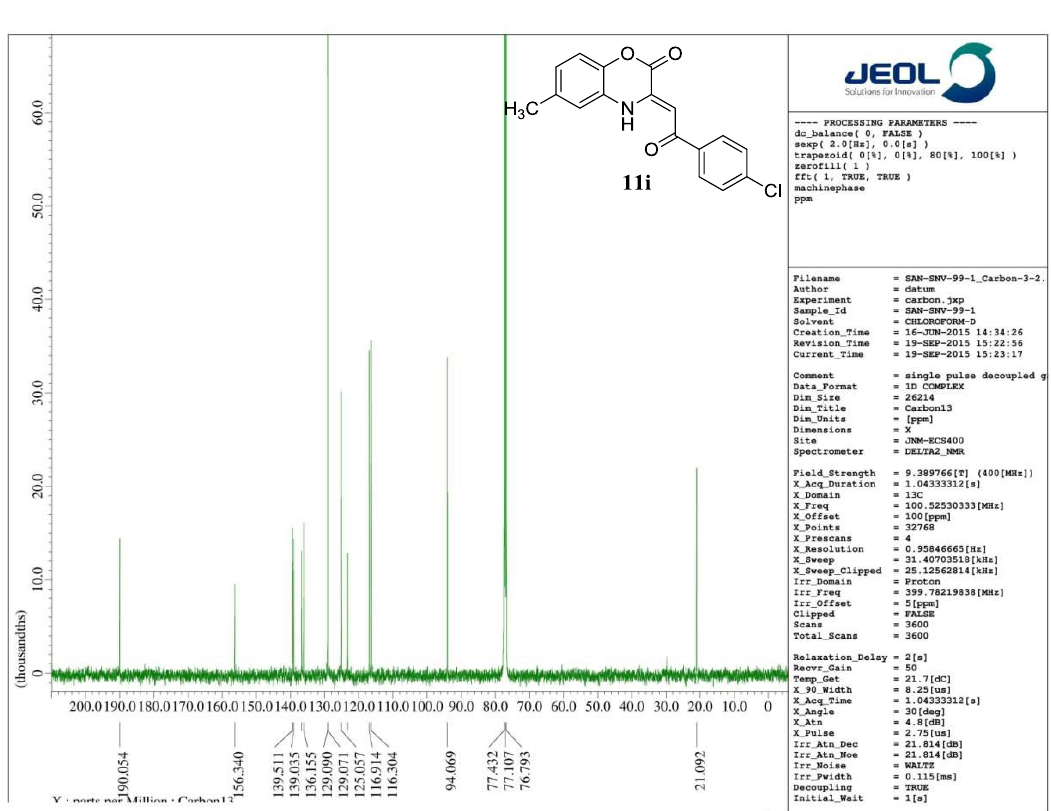
Figure 18. 13 C NMR Spectra of Compound 11i